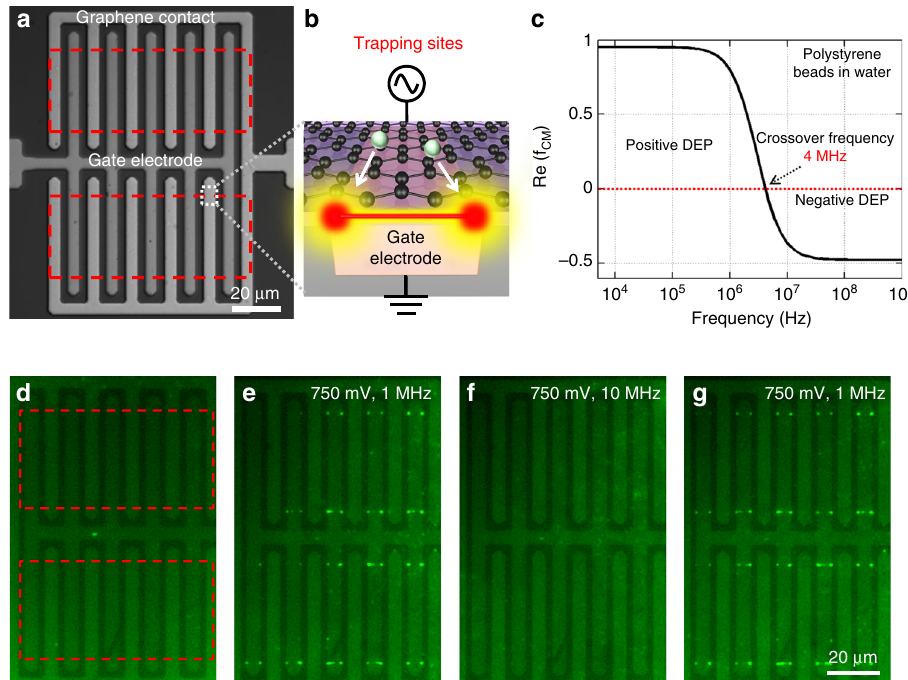
Fig. 3 DEP manipulation of 190 nm polystyrene beads using graphene electrode. a A bright fi eld microscopic image of the electrode design is shown with the location of the graphene patterns marked with red rectangles. b Applying an AC bias between graphene contact and the bottom gate electrode creates strong fi eld gradients at the graphene edge. However, the region of strongest fi eld strength resides at the intersection points of the graphene edge and the bottom electrode edge (red circles) —“ trapping sites ” . c Clausius-Mossotti (CM) factor plot for polystyrene beads in water with a conductivity of 4 μ S/cm. d A green background was observed before applying voltage from the bulk solution. e − g 190 nm polystyrene beads were trapped e at the trapping sites due to positive DEP (750 mV, 1 MHz). The beads can also be released f due to negative DEP (750 mV, 10 MHz) and then retrapped again g by applying positive